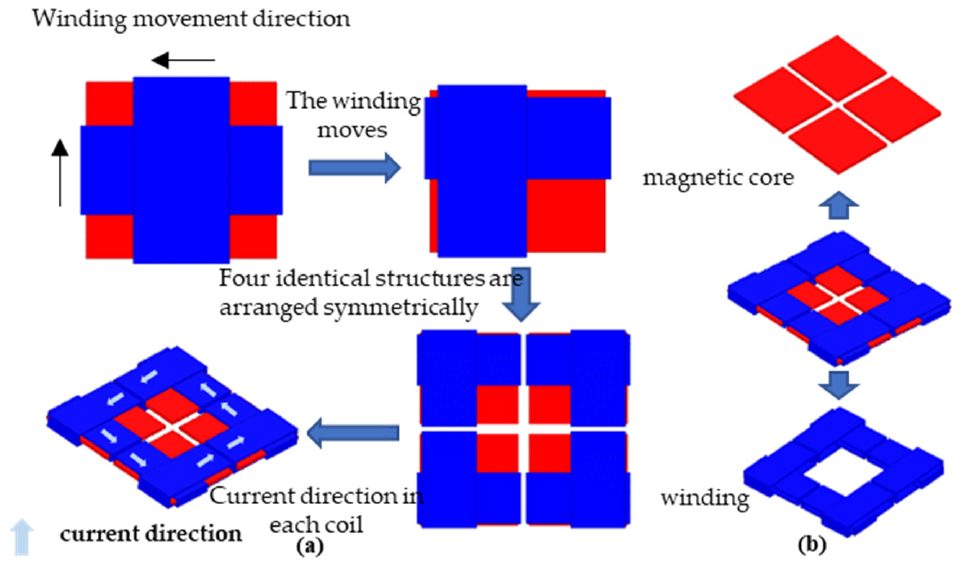
Figure 8. Derivation of the new coil structure: ( a ) coil structure derivation and current direction; ( b ) coil structure composition.